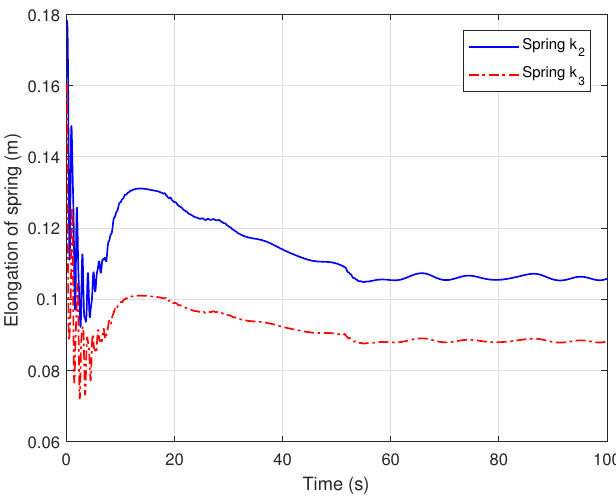
Figure 11. The elongation of springs under case I.